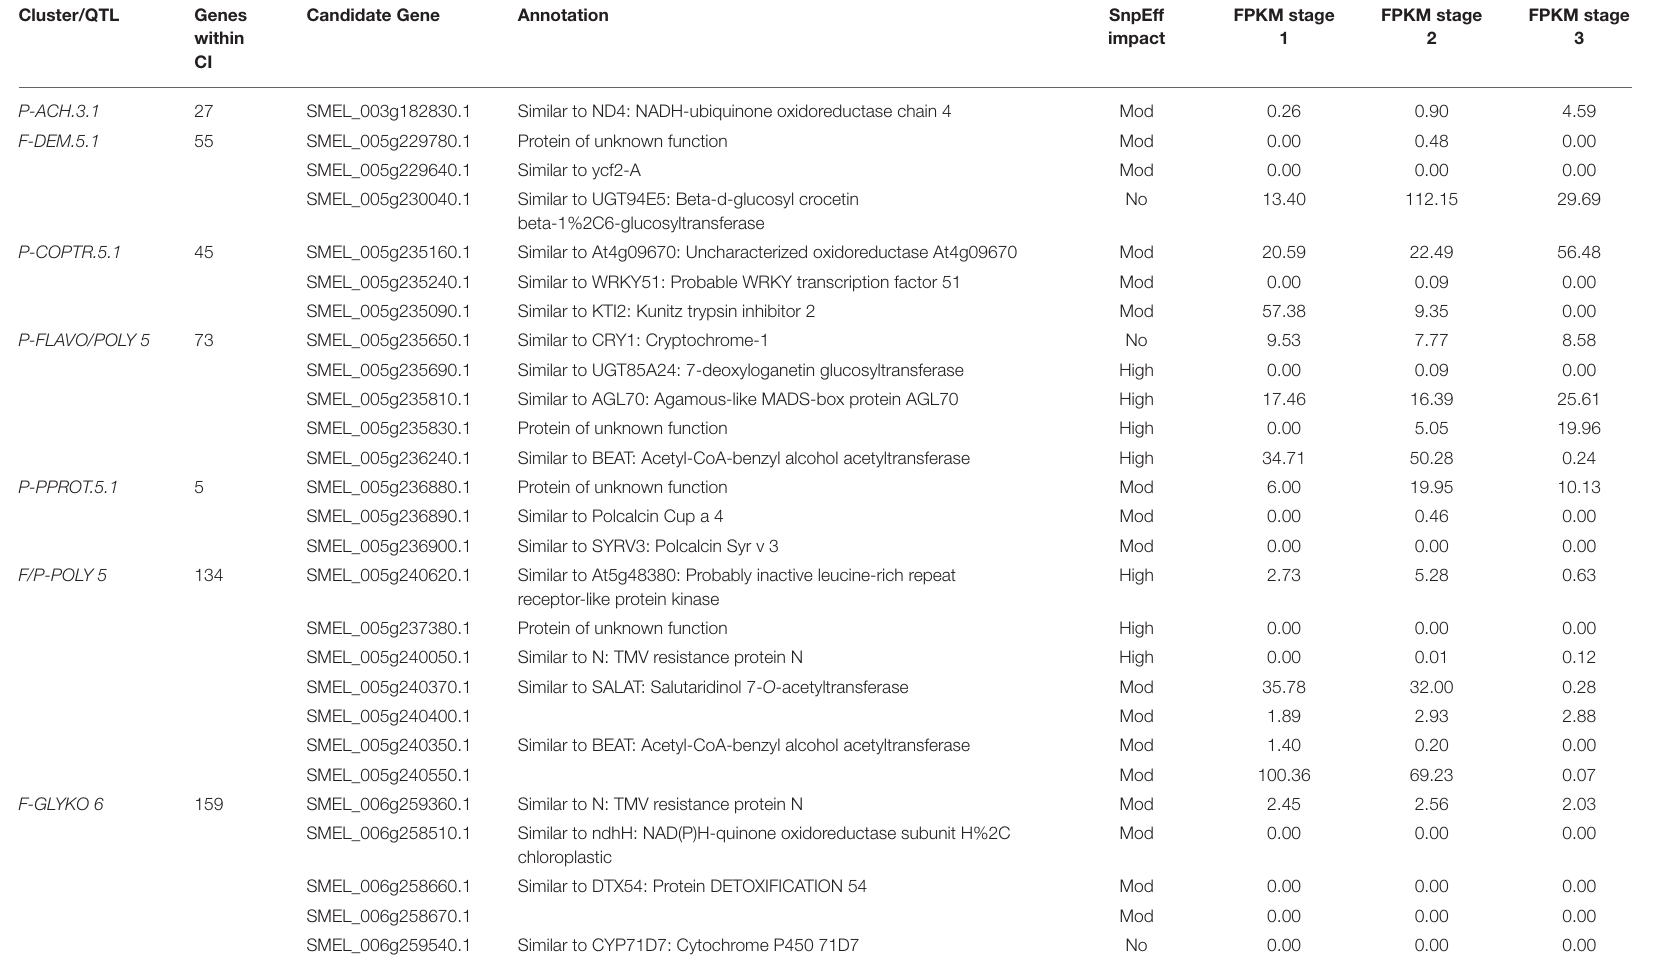
TABLE 3 | Candidate genes underlying the mQTLs and mQTL clusters. Cluster/QTL